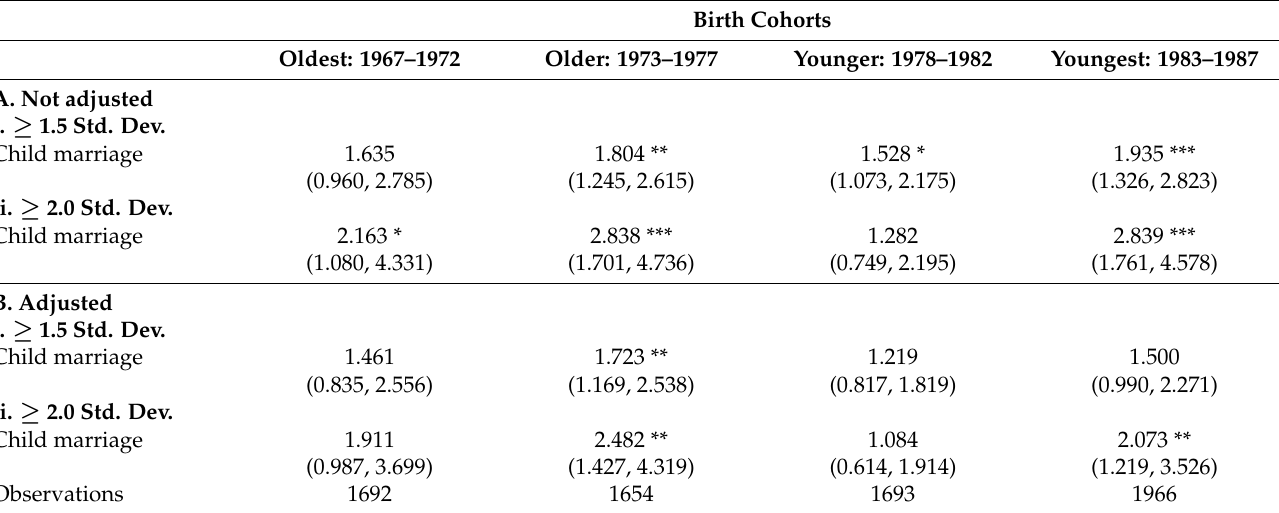
Table 5. Odds ratios in favor being obese (alternate measure) by birth